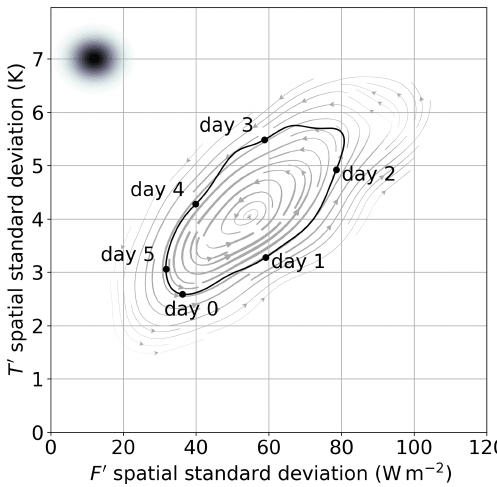
Figure 9. Closed trajectory in the phase space of F (cid:48) and T (cid:48) spatial standard deviations chosen for the computation of phase tendency evolution. Black dots along trajectory indicate time duration in days of each section. The size of the averaging Gaussian filter is indicated by the black-shaded dot in the upper-left